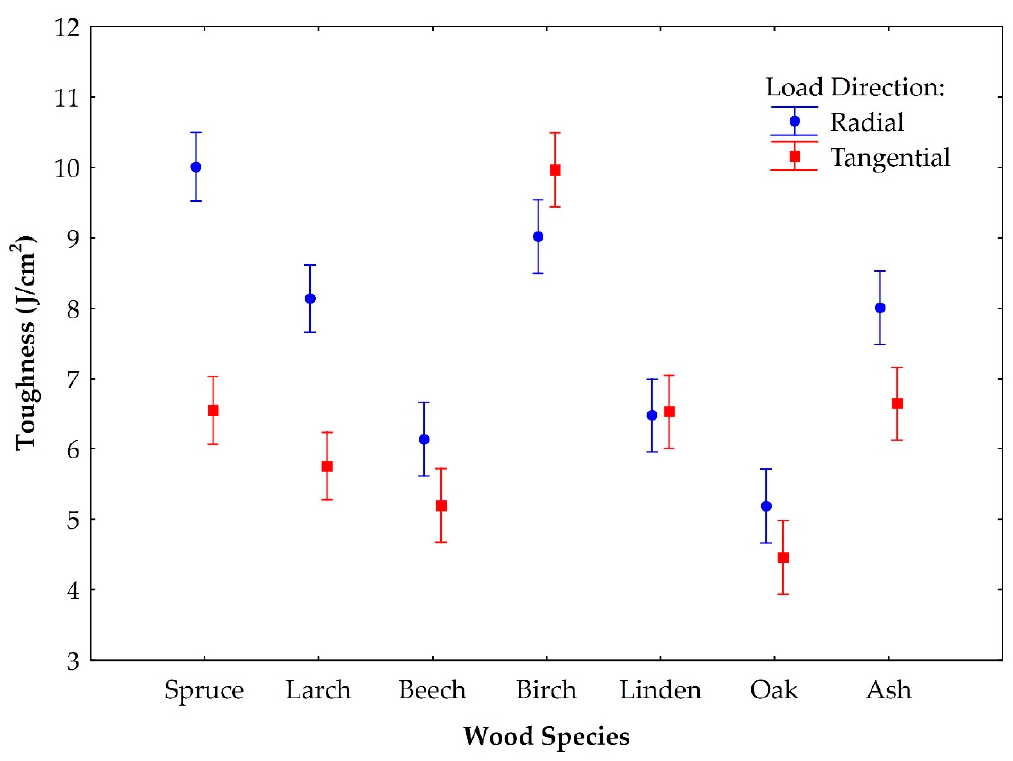
Figure 8. Graphic visualization of the effect of load direction on toughness (impact bending strength) for specific wood species.